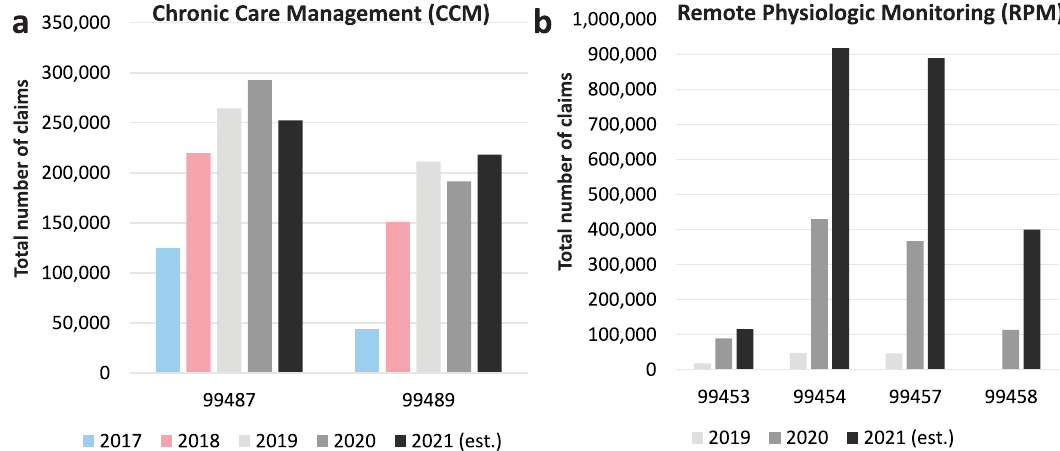
Fig. 1 CPT codes of Chronic Care Management (CCM) and Remote Physiologic Monitoring (RPM). a The CCM codes stand for: 99487: CCM services, with the following required elements: multiple (two or more) chronic conditions expected to last at least 12 months, or until the death of the patient; fi rst 60 min of clinical staff time directed by a physician or other quali fi ed health care professional, per calendar month; 99489: add-on code: each additional 30 min of clinical staff time directed by a physician or other quali fi ed health care professional, per calendar month. b The RPM codes are de fi ned as: 99453: RPM parameter(s) (e.g., weight, blood pressure, pulse oximetry, respiratory fl ow rate), initial; set-up and patient education on use of equipment; 99454: Device(s) supply with daily recording(s) or programmed alert(s) transmission, each 30 days; 99457: RPM treatment management services, 20 min or more of clinical staff/physician/other quali fi ed healthcare professional time in a calendar month requiring interactive communication with the patient/caregiver during the month; 99458: RPM treatment management services, clinical staff/physician/other quali fi ed health care professional time in a calendar month requiring interactive communication with the patient/caregiver during the month; additional 20 min.